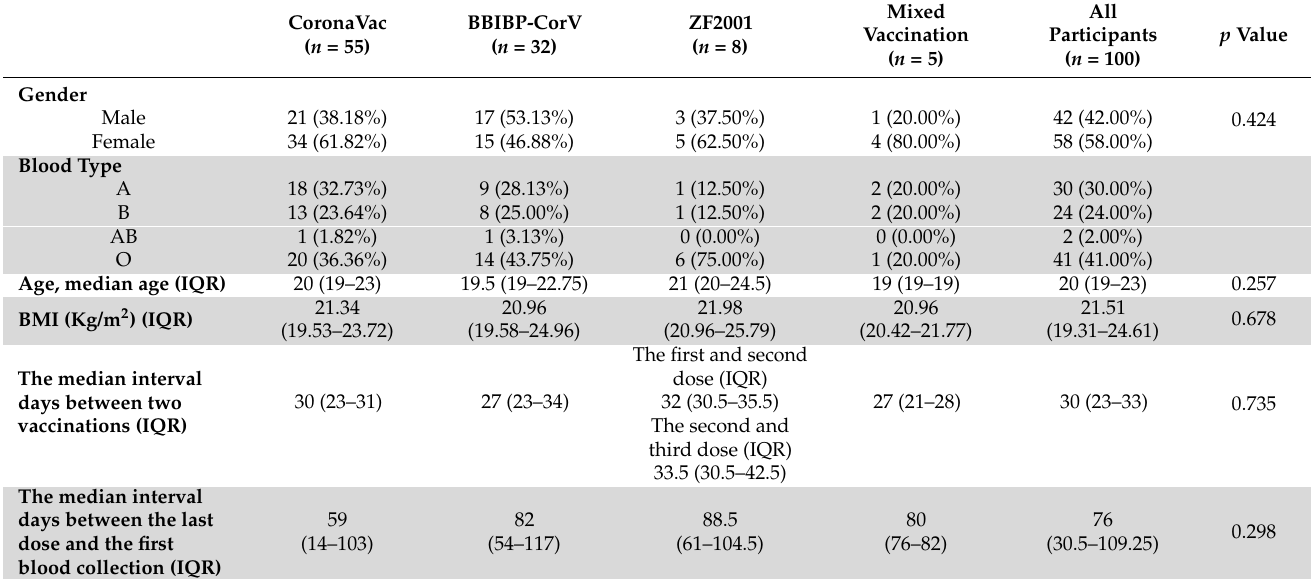
Table 1. Demographic characteristics of study subjects with COVID-19